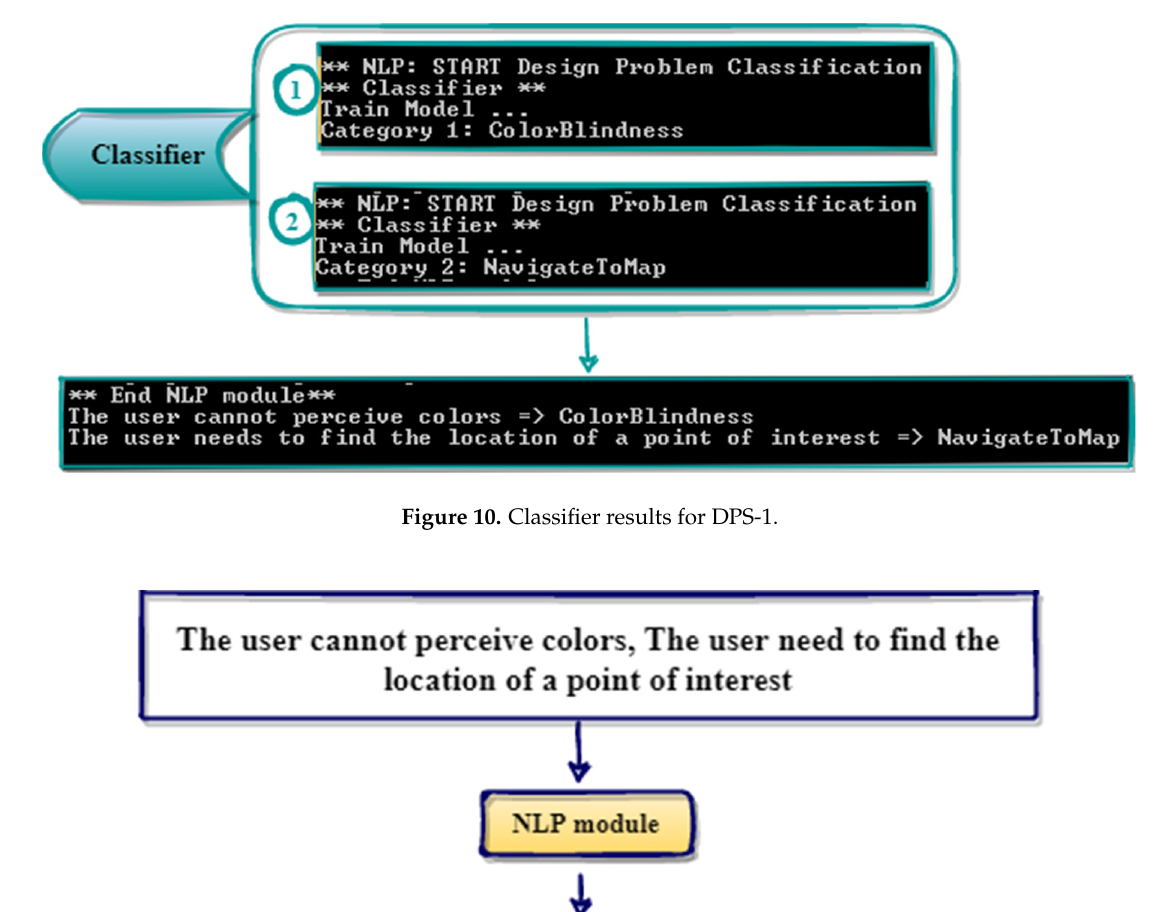
12 of 26 Figure 8. Splitter results for DPS-1. Then, in the tokenizer step, the two atomic design problems were tokenized using the Tokenizer API. As illustrated in Figure 9a, each sentence was transformed into an ob- ject wherein each word was represented as a small fragment, called a token. Next, in the POS tagger step, the NLP module assigned POS tags to tokens obtained from the tokenizer step. All tokens were marked with their POS tags, as shown in Figure 9b. ( a ) ( b ) Figure 9. Results for DPS-1: ( a ) tokenizer results; ( b ) POS tagger results. Finally, based on the tags assigned in the previous step, only nouns and verbs were